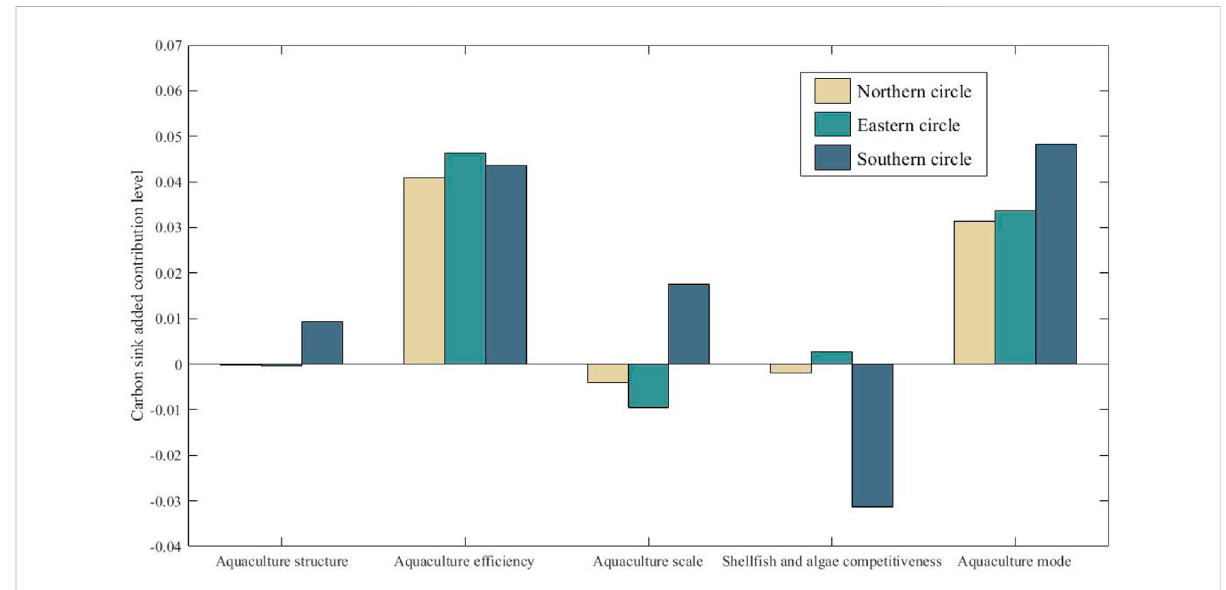
FIGURE 5 Level of contribution of different factors increases carbon sink in the three marine economic zone.